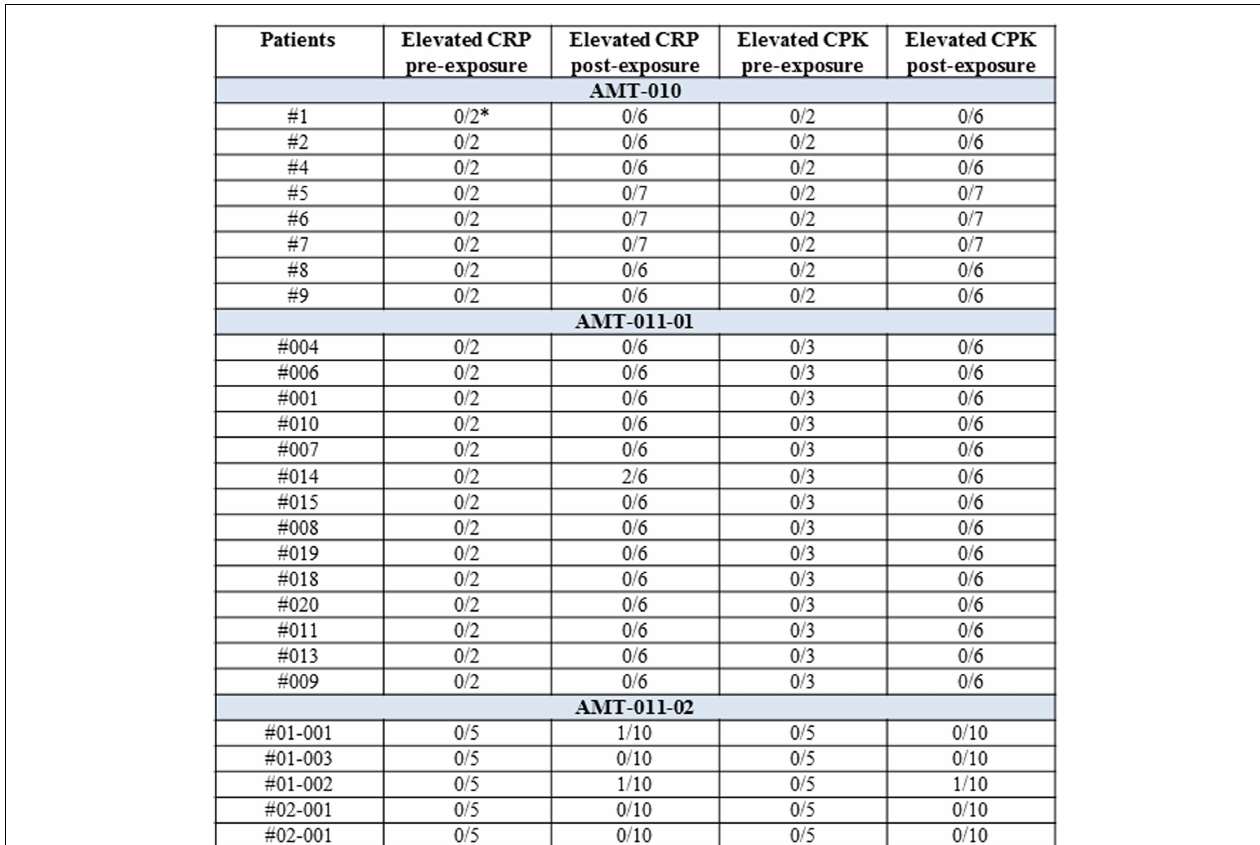
AMT-011-01, the isolated elevation of CRP for subject 014 was concomitant with a transient medical condition. In the study AMT-011-02, the isolated elevation of CRP for subject 01-001 was concomitant with a transient medical condition.The isolated elevation of CRP and CPK for subject 01-002 was related to the general clinical condition of the